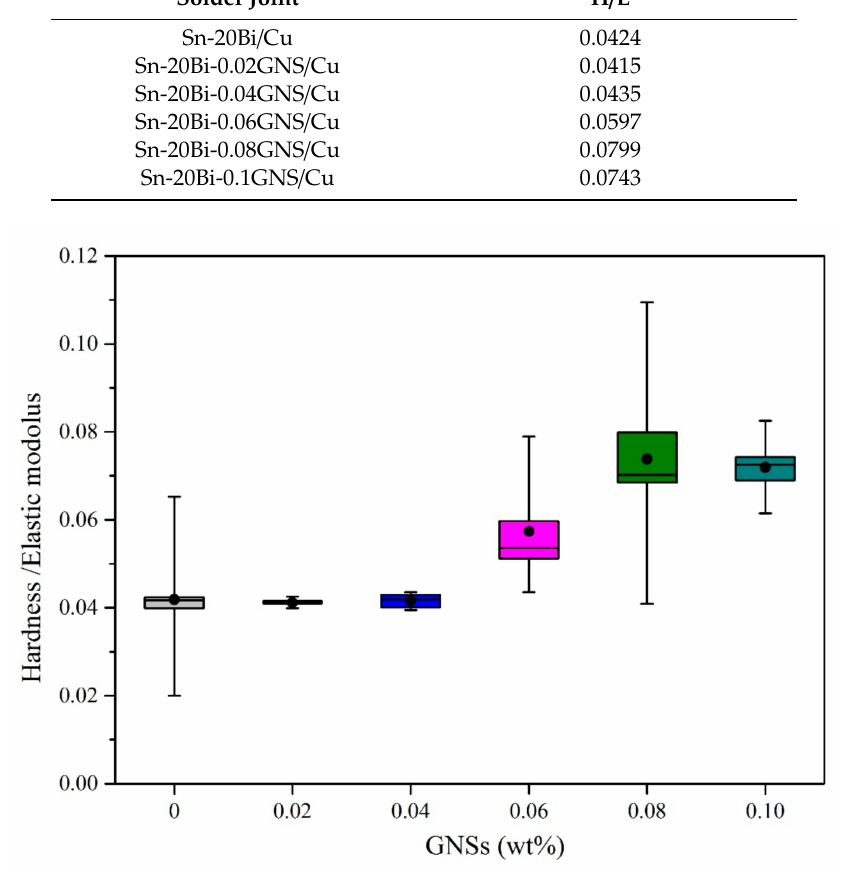
Figure 10. The ratio of hardness / elastic modulus of IMCs at the Sn-20Bi-xGNS / Cu composite solder